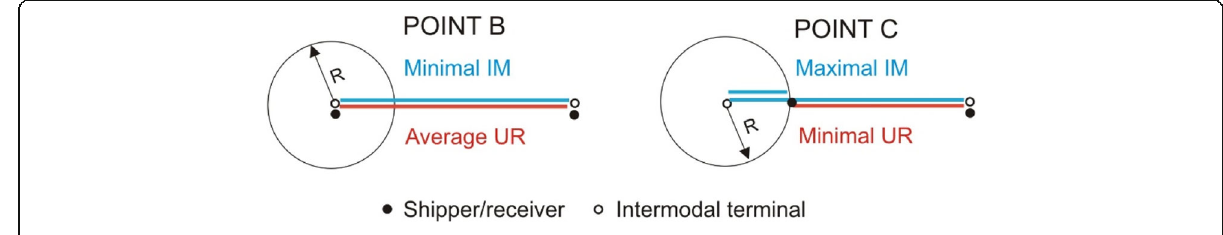
Fig. 10 Limit points in the one-sided drayage